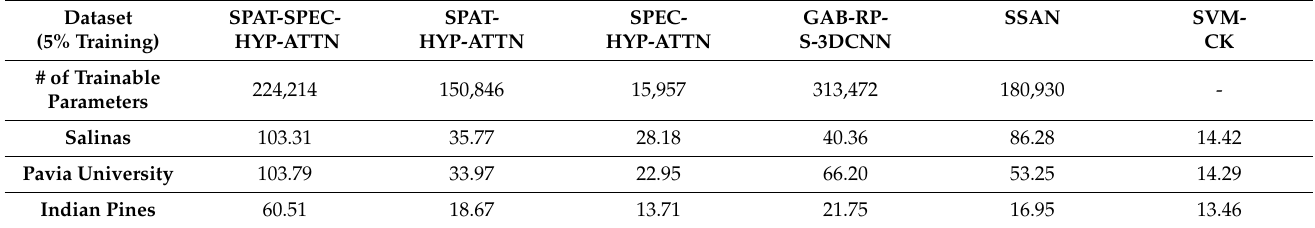
Figure 9. Overall classification accuracies of Indian Pines dataset for varying size of training samples. Table 7. Overall execution time (in minutes) of all the methodologies in comparison for 5% train- ing